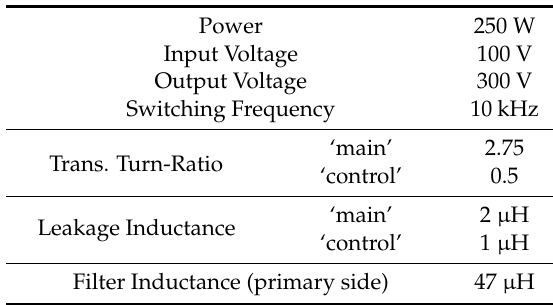
Figure 12. A small-scaled prototype of the BiDUP converter for laboratory experiment. Table 3. Prototype specifications.